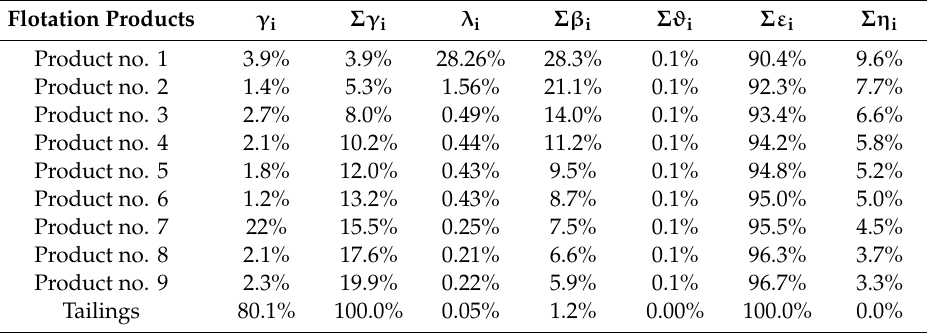
Table 7. A balance of flotation parameters of copper ore with particle size distribution of 40–71 µ m in the Denver flotation machine by means of an aqueous solution of ethyl sodium xanthate in the dose of 100 g / Mg.